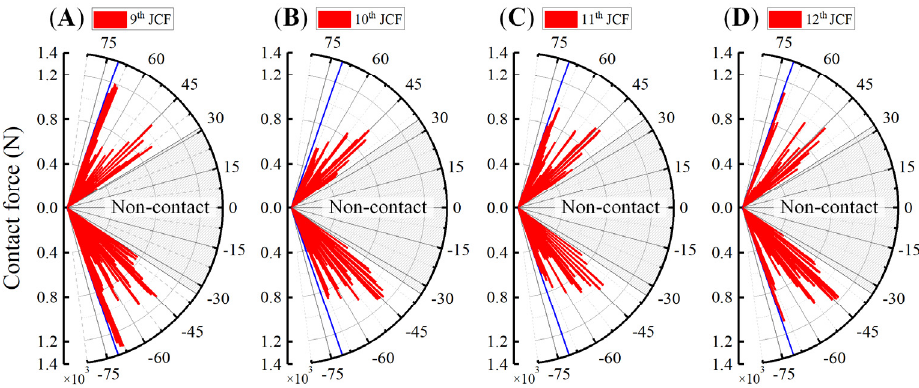
Figure 19. Non-contact zone: ( A ) JCF of the 9th module; ( B ) JCF of the 10th module; ( C ) JCF of the 11th module; and ( D ) JCF of the 12th